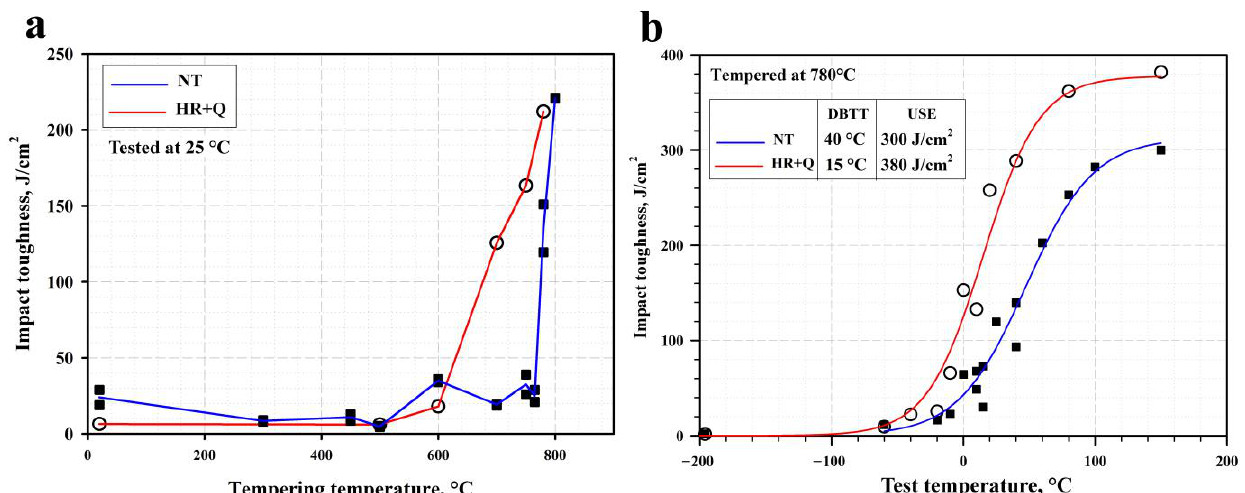
Figure 3. The effect of tempering temperature on the impact toughness of the NT and HR+Q samples ( a ) and the Charpy impact absorbed energy vs. impact test temperature curves of the NT and HR+Q samples tempered at 780 °C for 3 h ( b ).